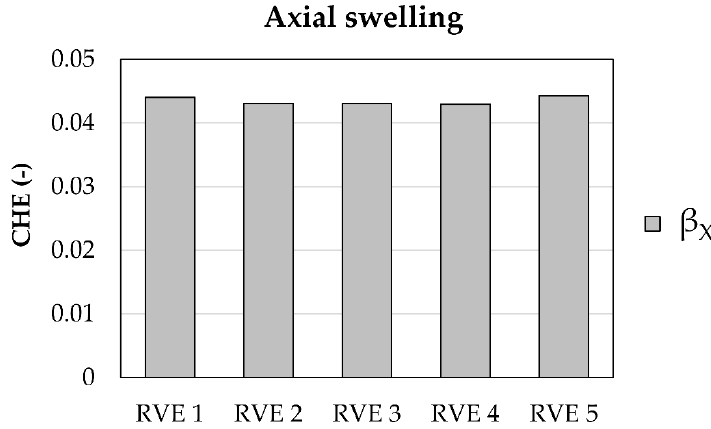
Figure 8. Swelling coefficients in transverse directions y and x for the five RVEs used in the simulations.